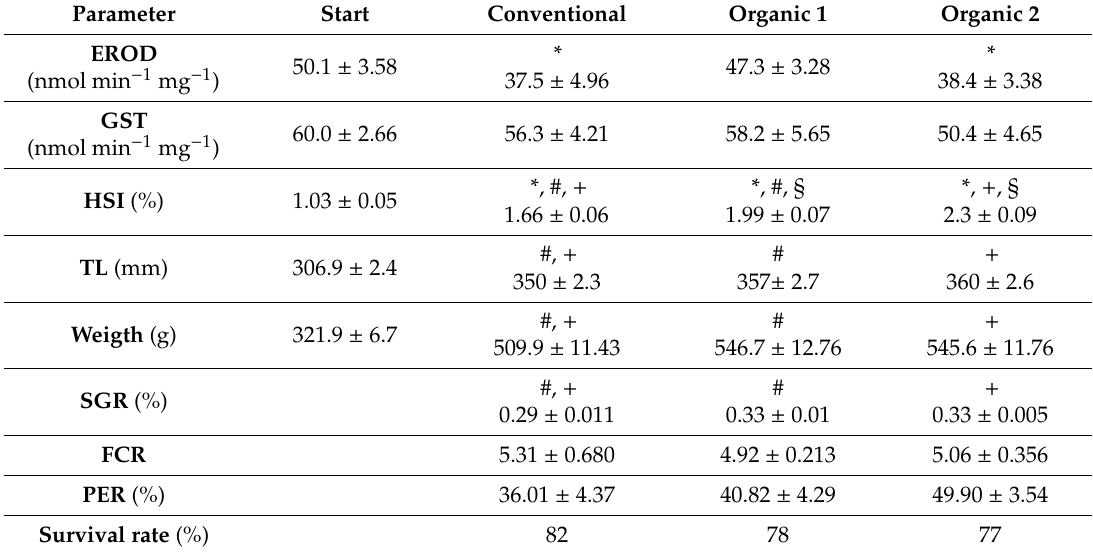
Table4. Mean ± SEMofERODandGSTactivitiesandthegrowthparametersduringtheexperimentation for the three diets (Conventional, organic 1 and